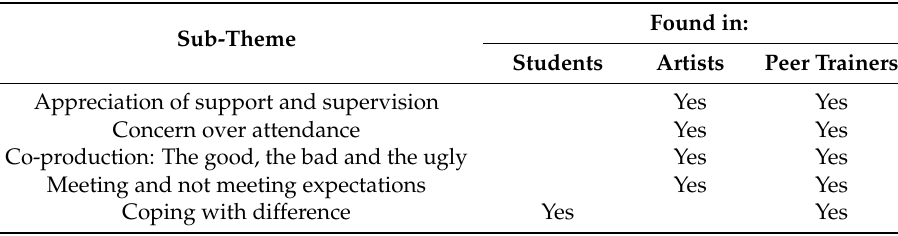
Table 6. Components of the main theme ‘Overcoming